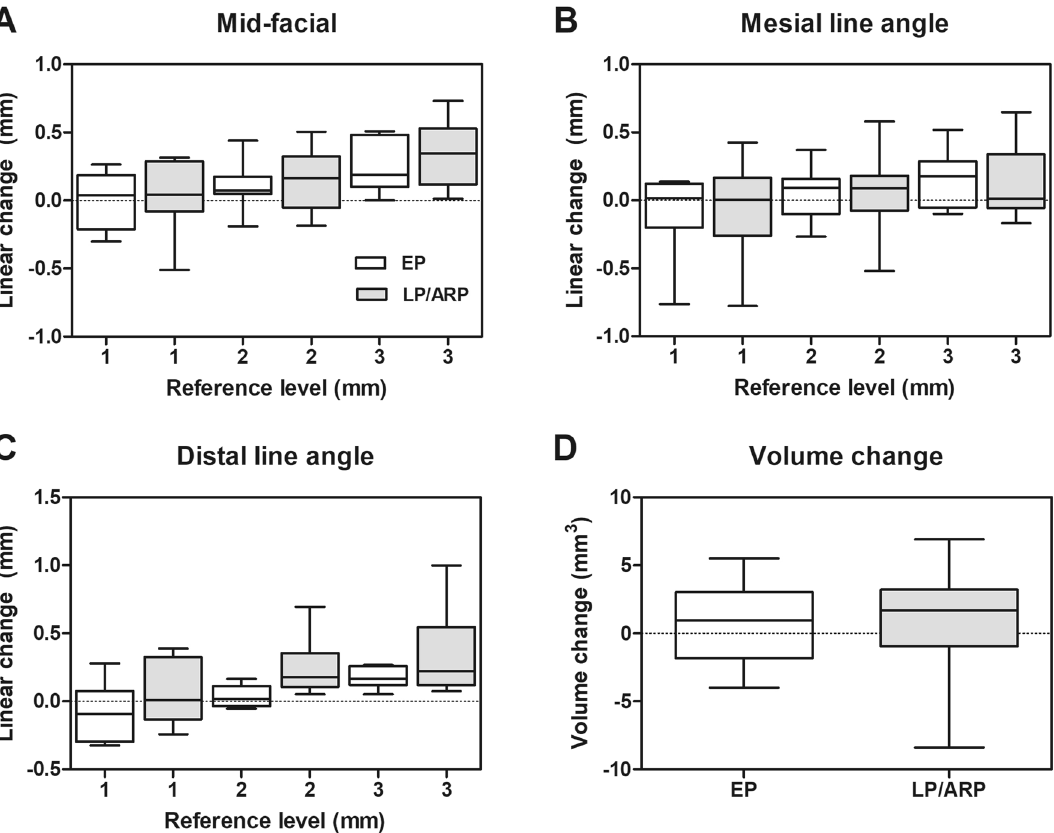
Figure 3. Graphs for linear tissue change and volume change in the area of interest from immediately after the final prosthesis insertion and after 12 months. ( a ) Linear difference at the mid-facial line. ( b ) Linear difference at the mesial line angle. ( c ) Linear difference at the distal line angle. ( d ) Volume difference. Positive and negative numbers indicate gain and loss, respectively. The whiskers cover the whole range of the data.